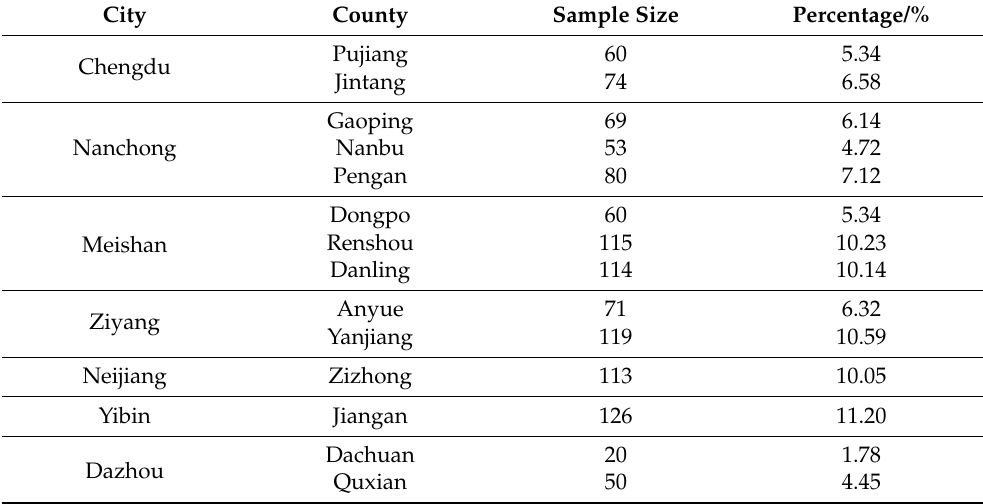
Table 1. Sample size